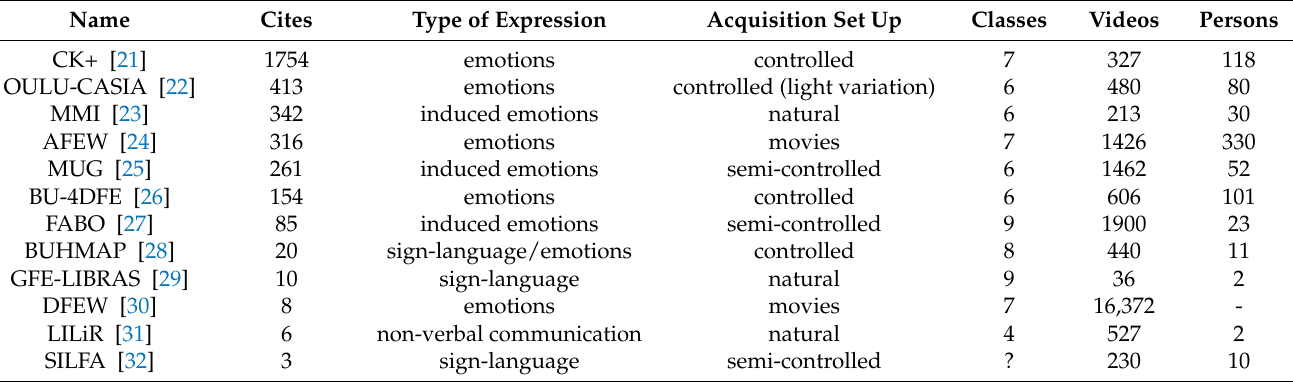
Table 2. Main datasets collected for dynamic facial expression